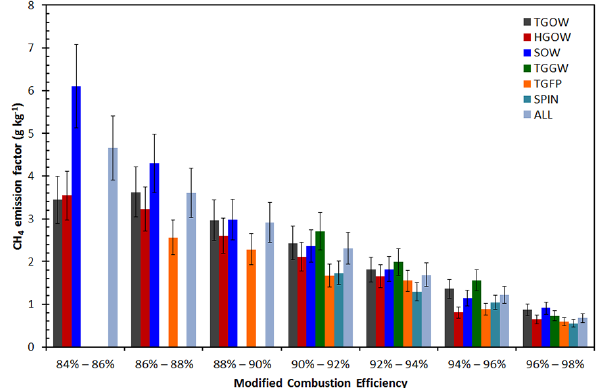
Figure 13. The emission factor for CH 4 (EF CH 4 ) grouped by MCE, calculated using the emission ratios determined from 2%- wide MCE bins for different vegetation classes, and for all mea- surements combined (error bars indicate the estimated uncertainty calculated in accordance with Paton-Walsh et al.,